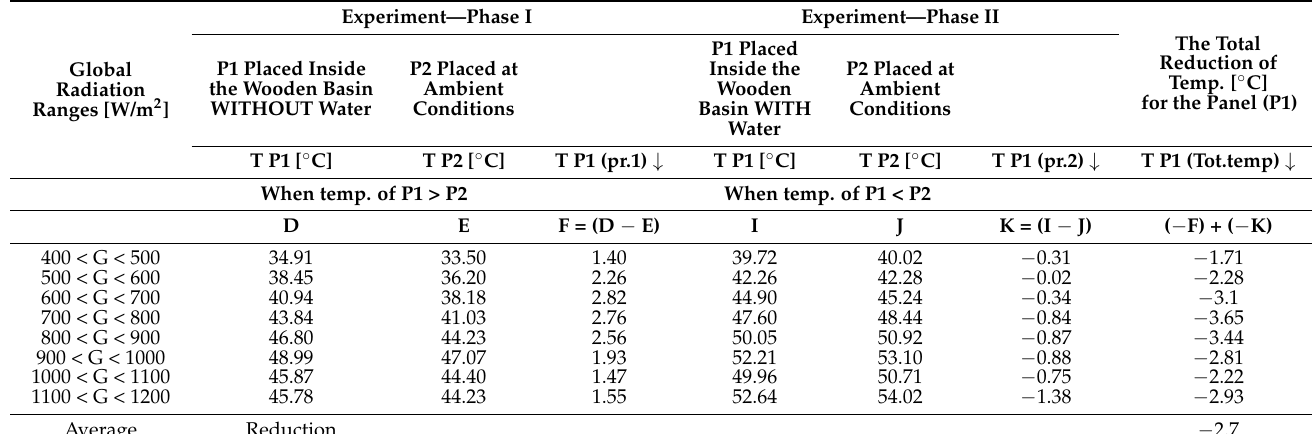
Table 2. P1’s Total temperature reduction (the panel under